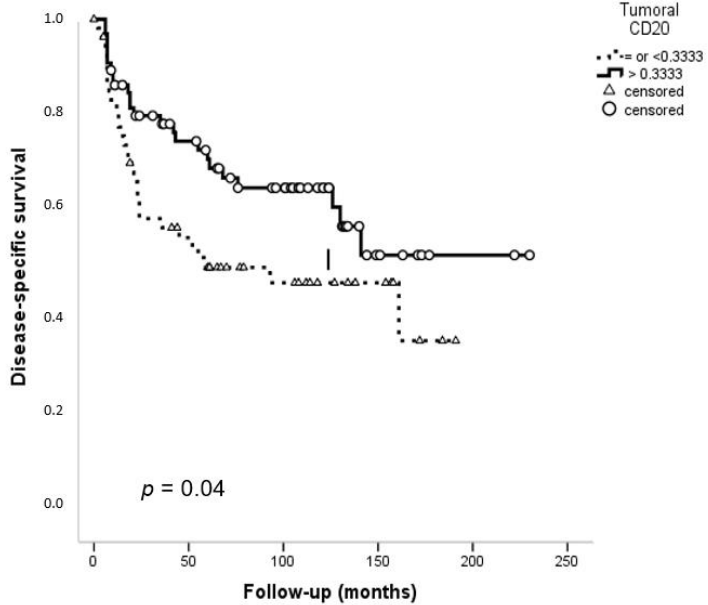
Figure 3. Kaplan–Meier disease-specific survival curves in the cohort of 125 OSCC patients catego- rized by tumoral CD20 + B cell infiltration. Median values were used as cut-off points. p values were estimated using the log-rank test.